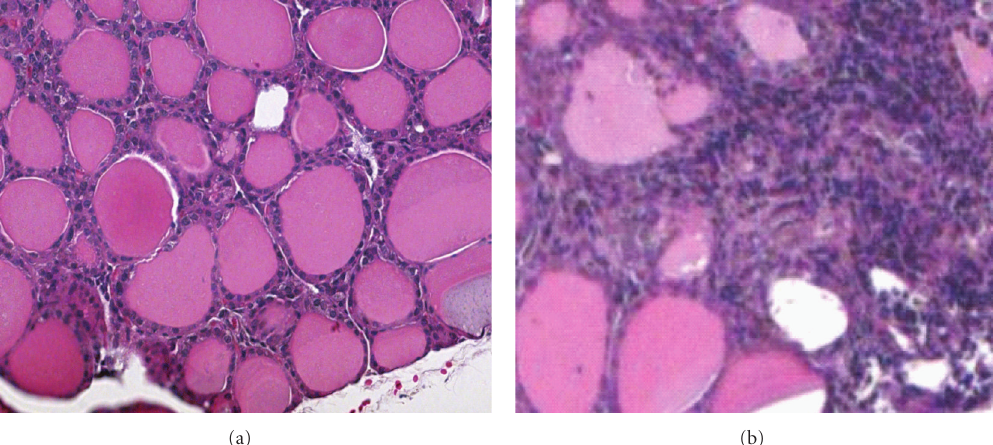
Figure 1: A representative figure of thyroid gland histology from a control mouse and a adaptively transferred with NKT cell line 1F1.1 is shown after hematoxylin and eosin (H & E) staining. (a) Normal thyroid histology showing follicles surrounded with thyrocytes. (b) Section from thyroid gland after 14 days after adoptive transfer of iNKT cells line 1F1.1. Cellular infiltration and disruption of normal thyroid histology was observed. The thyroid histology was assessed as a 5-point score as described in Table 1.